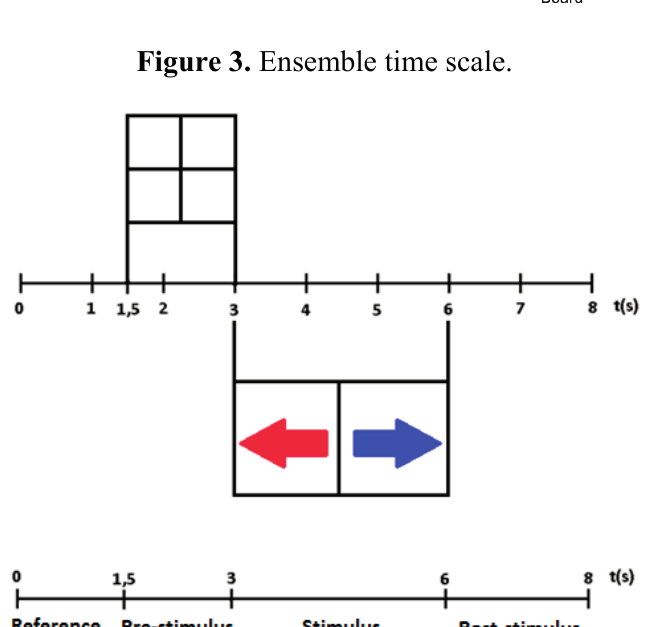
Figure 3. Ensemble time